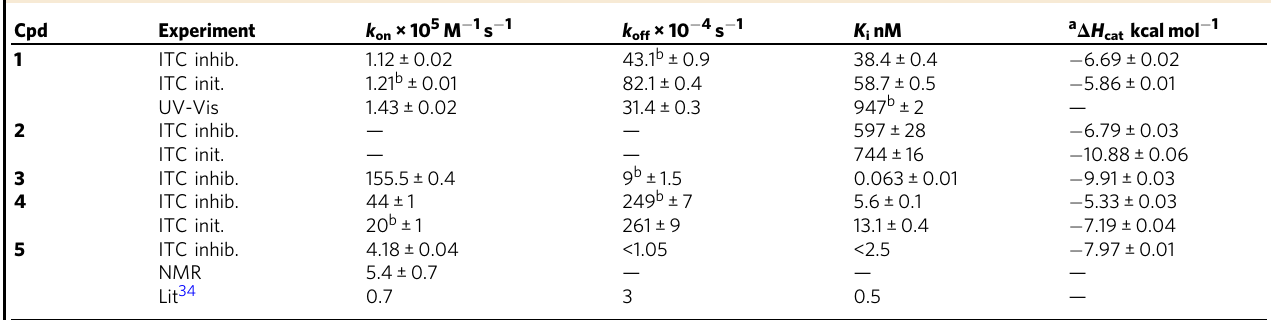
Table 1 Kinetic and thermodynamic